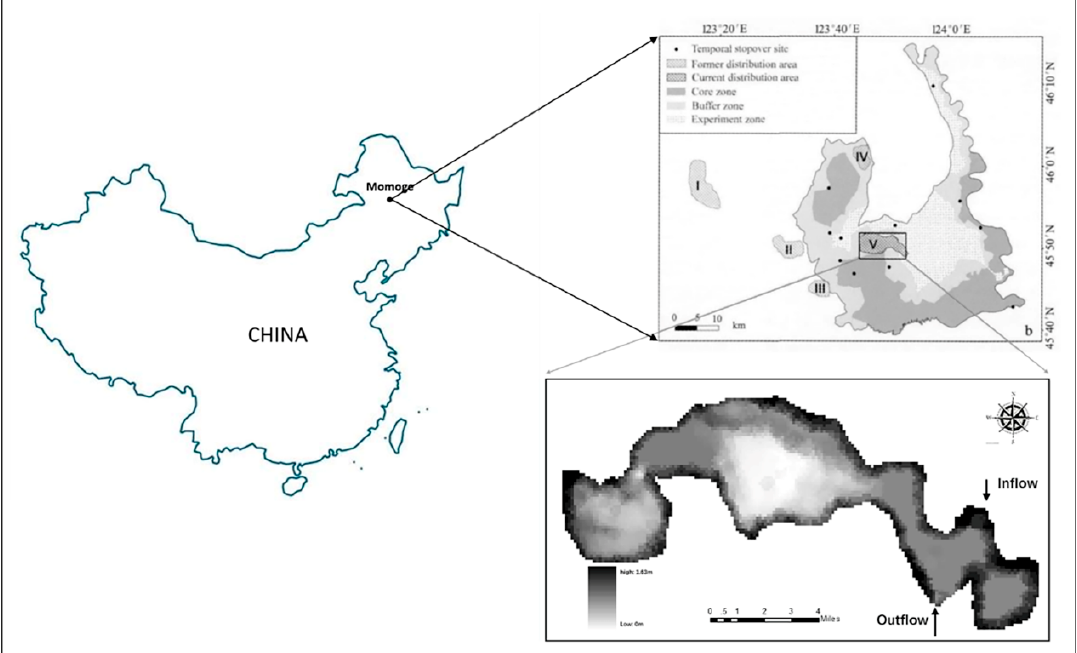
Figure 1. Geographical location and topographic conditions of Baihe Lake (Datum: 45°56’ N, 122°45’ E).